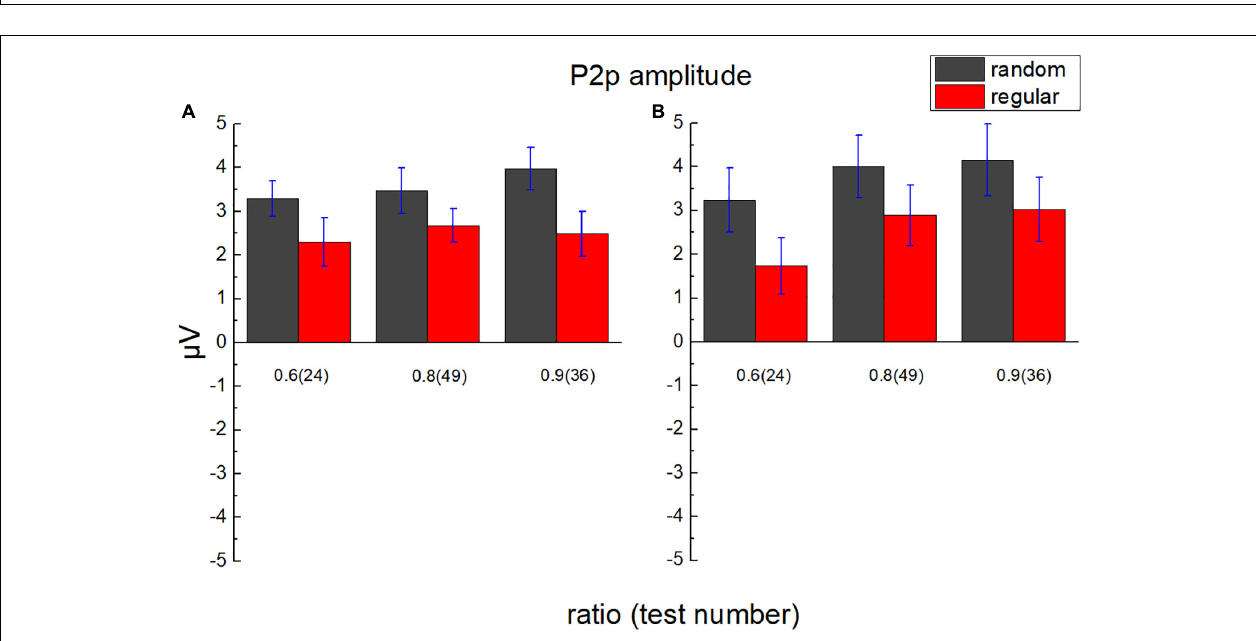
FIGURE 8 | Average P2p amplitude in the parietal lobe and the occipital lobe. (A) The average amplitude of ERP of participants in the parietal lobe from 200 to 250 ms after test presentation (P2p) is demonstrated according to different test ratios (0.6, 0.8, and 0.9). (B) P2p in the occipital lobe. Black bars stand for the randomly distributed patterns, and red ones stand for the regularly distributed patterns. Error bars denote 1 SE of the mean.